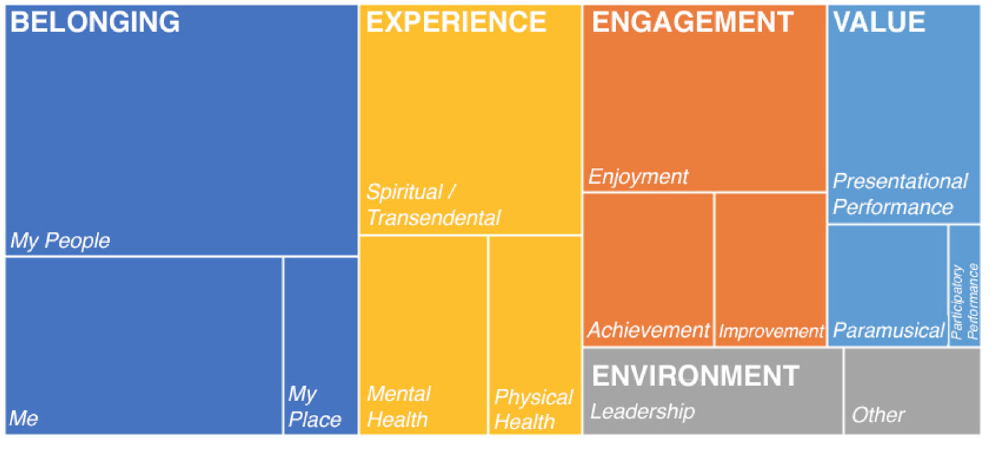
Fig. 7 Layer 1 coding density summary: non-Fellowship.